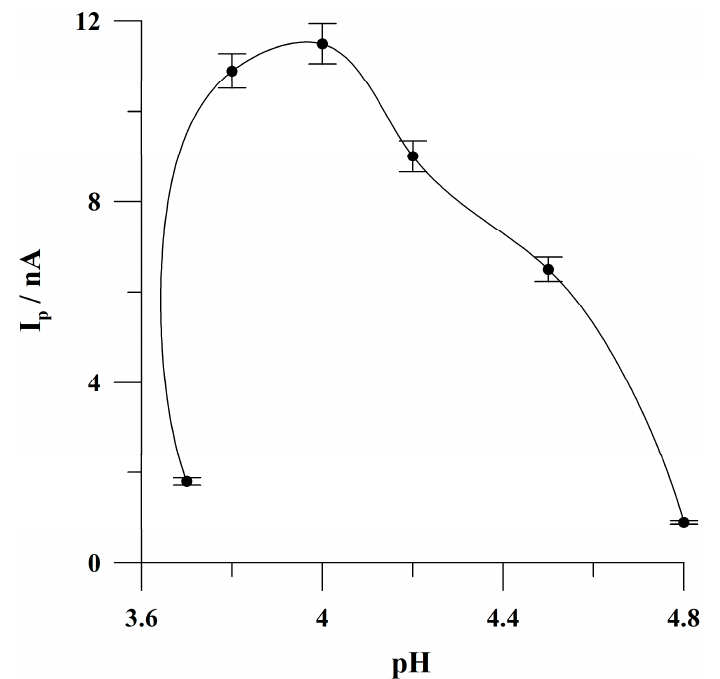
Figure 3. Effect of pH of acetate buffer on uranium signal. U(VI) concentration: 5 × 10 − 8 mol L − 1 . Accumulation conditions: − 0.7 V, 120 s. The error bars refer to the standard deviation (n = 3).